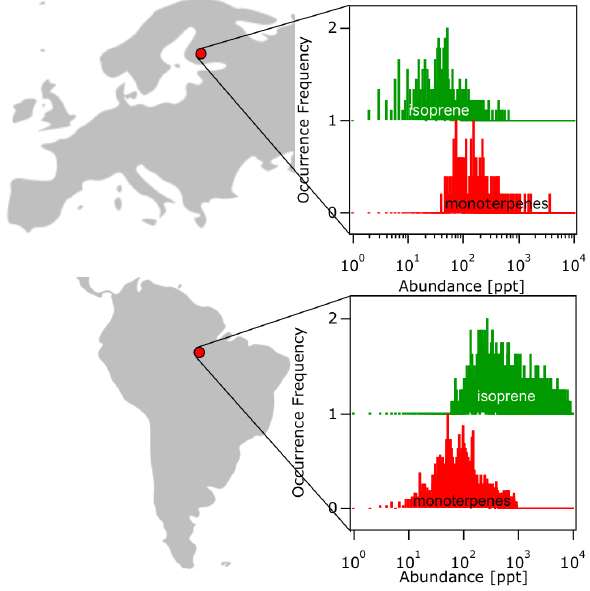
Fig. 6. Normalized histograms of the isoprene and monoterpene concentrations recorded in Southern Finland during the HUMPPA- COPEC-2010 field intensive (top) and in the central Amazon basin during the 2008 wet season (bottom). Isoprene data offset for clarity in each